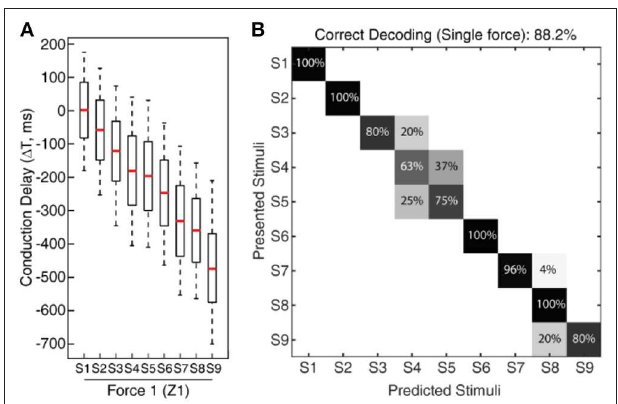
FIGURE 5 | Classification of CNs responses across all 9 stimuli for fixed sensing force. (A) Boxplot illustrating the spiking probability for CNs responses ( Figure 4C ) across all the nine stimuli for a given force. The boxplot demonstrates a gradual shift in the CNs spiking respective to the stimuli angle and conduction delay. The spiking probability is calculated across 5 experimental repetitions of each CN. (B) Confusion matrix demonstrates a decoding performance achieved across all the 9 stimuli (for a fixed sensing force (Z1) and sensing velocity (5 mm/s)) based on CNs responses, using supervised linear discrimination classifier. The decoding accuracy was 100% across 5 stimuli with a step size of 10 ◦ (S1, S3, S5, S7, and S9), and 88.2% with a step size of 5 ◦